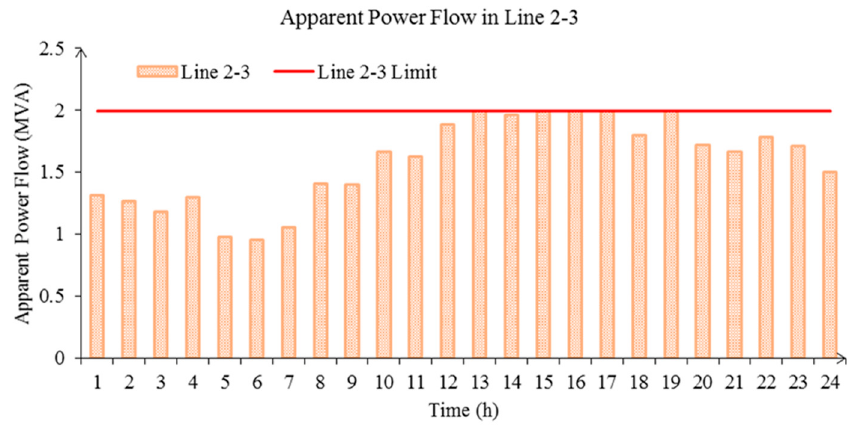
Figure 9. Apparent power flow in Line 2–3 demonstrating line limits are not exceeded.